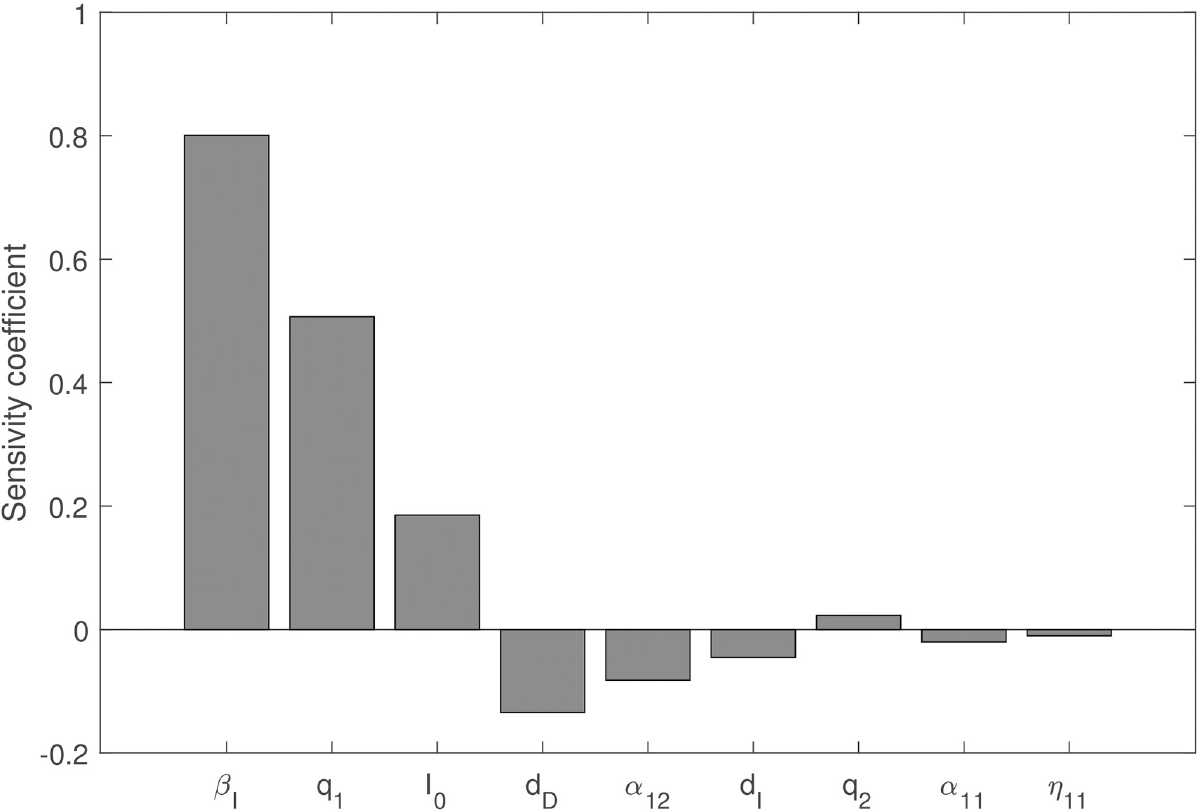
Fig 9. The sensitivity analysis of SSE . Latin Hypercube Sampling method is used to analyze the sensitivity of 100,000 samples. All parameter values are the same as in Table 3.